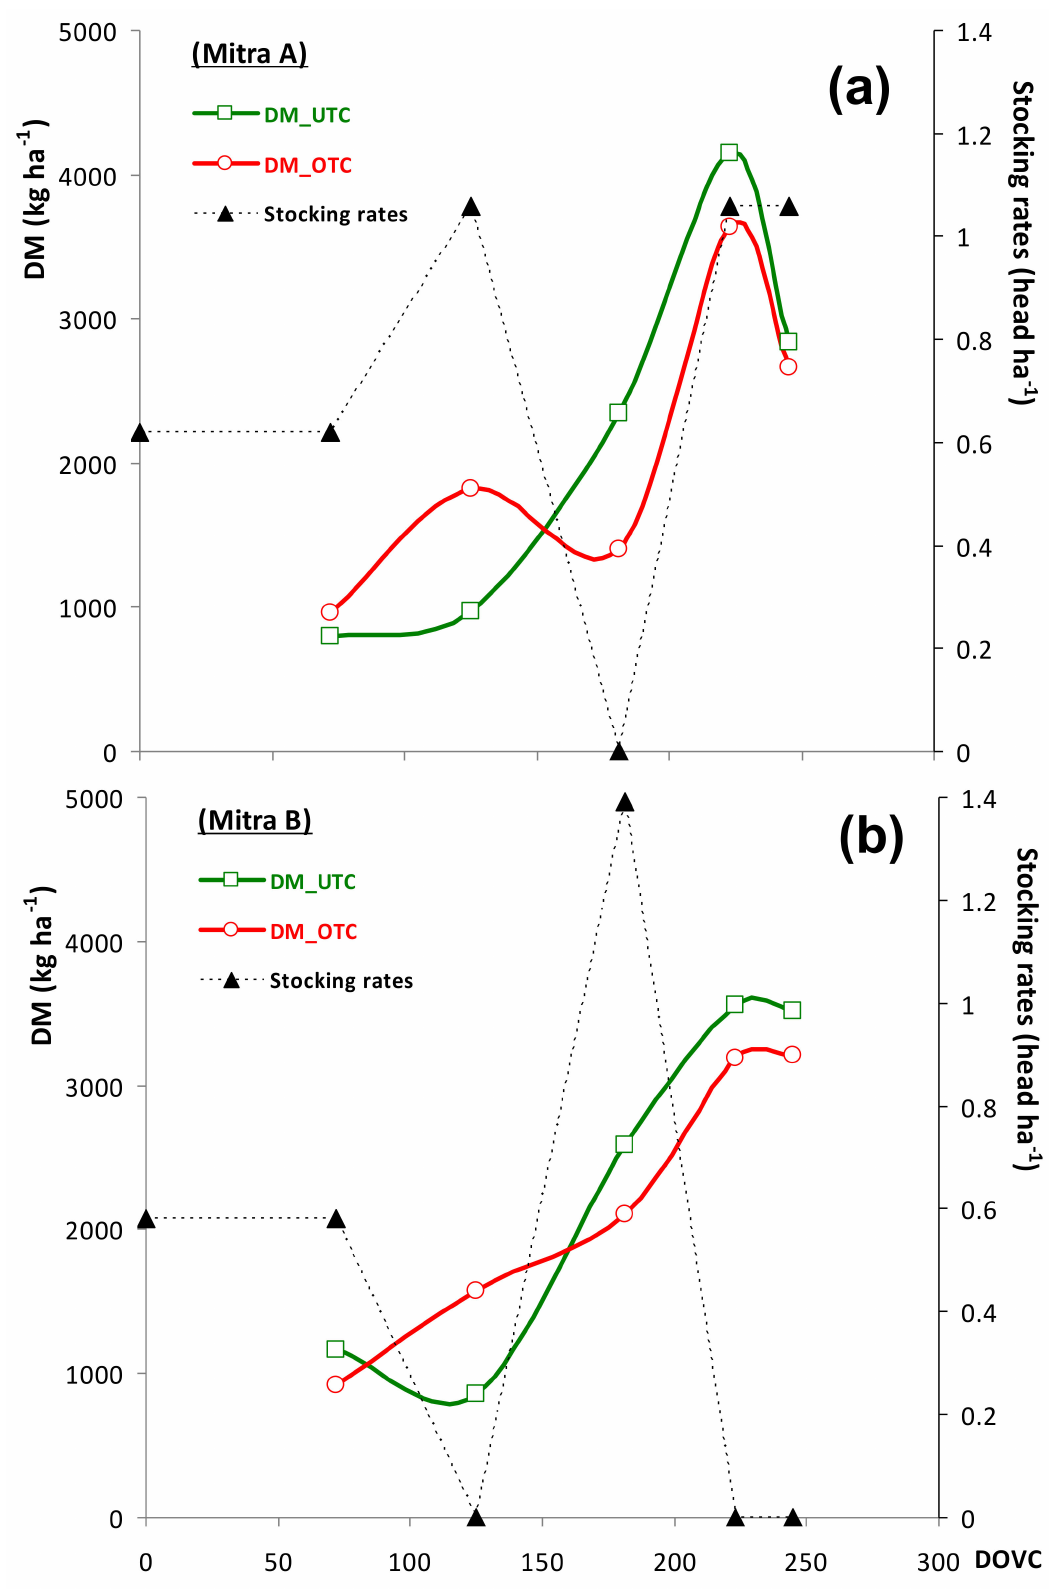
Figure 7. Evolution of the pasture productivity (dry matter, DM, kg ha − 1 ) throughout the vegetative cycle, in “Field A” ( a ) and “Field B” ( b ), under tree canopy (UTC) and outside tree canopy (OTC). DOVC, day of the pasture vegetative